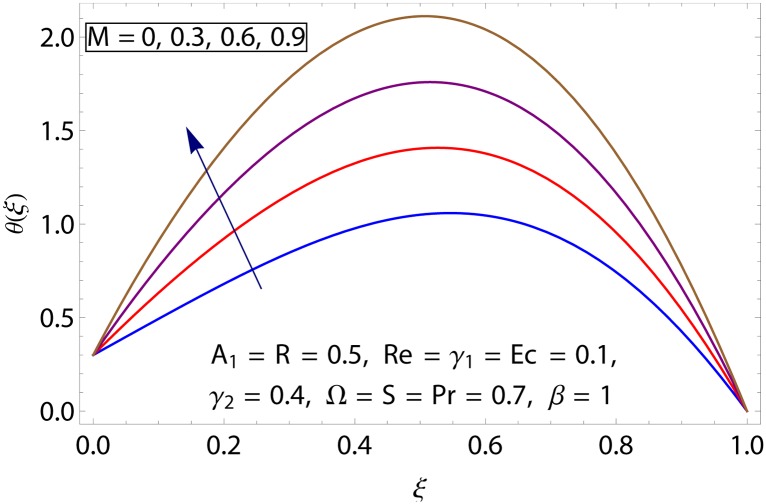
Impact of M on θ(ξ).